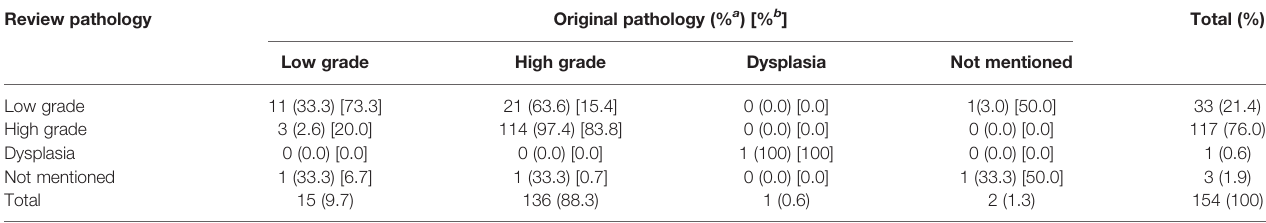
TABLE 4 | Interobserver variation for tumor